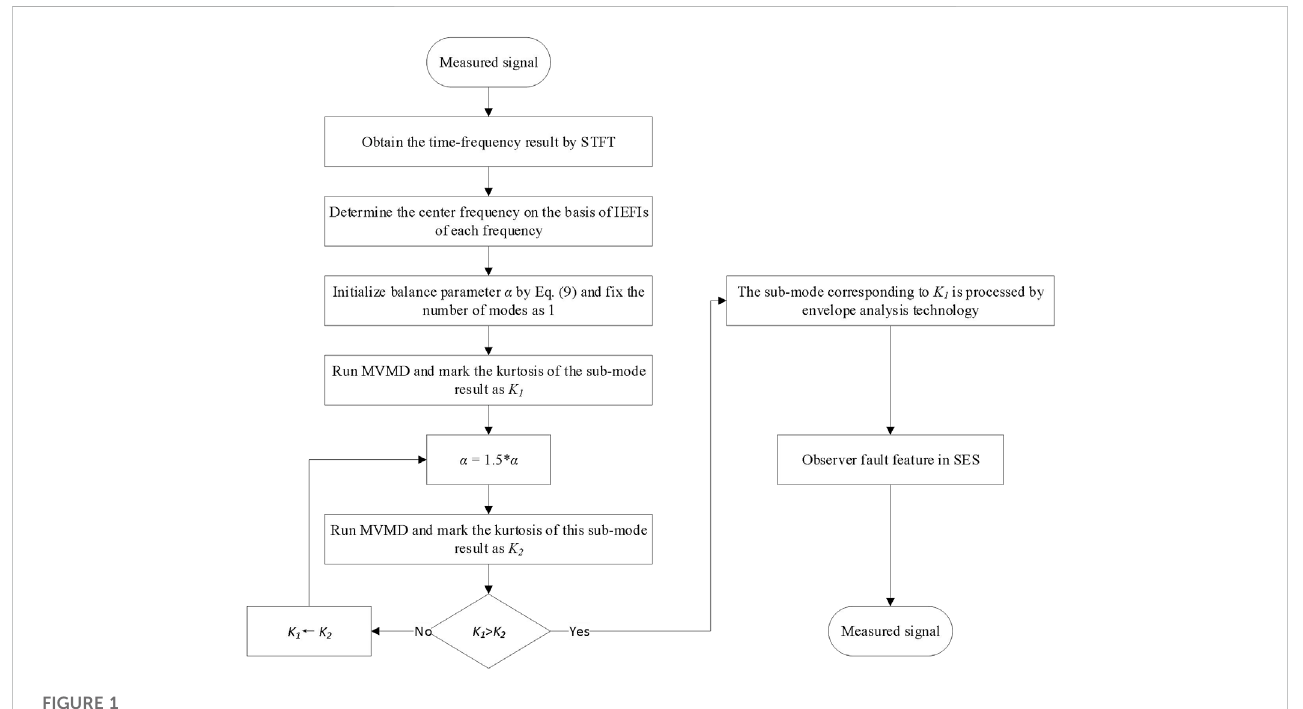
FIGURE 1 Flowchart of IEFI –